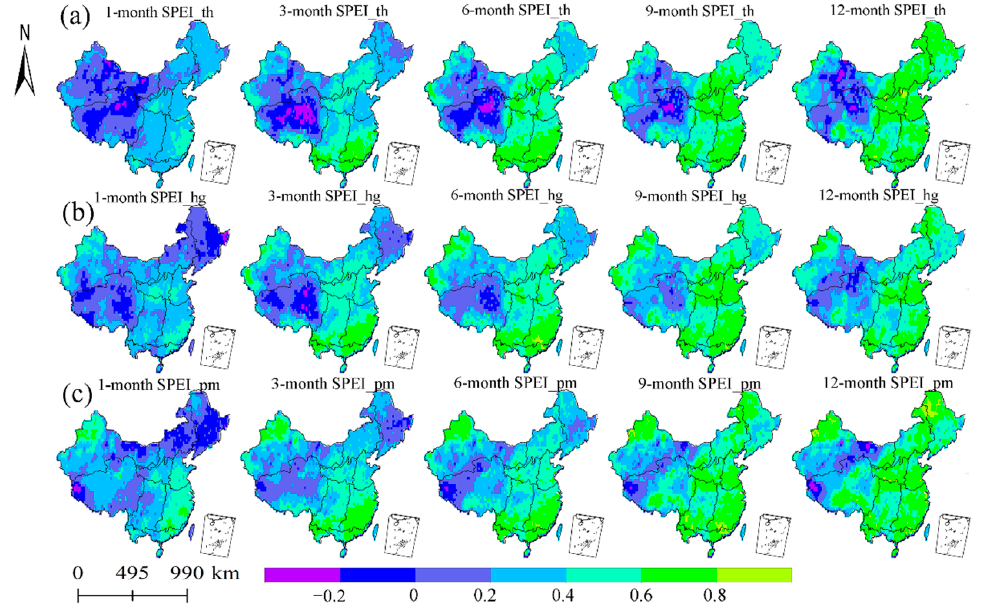
Figure 3. The correlation between monthly SPEI based on multiple PET equations (( a ) TH, ( b ) HS, ( c ) PM) and soil moisture anomalies in China over the period of 1961–2018.